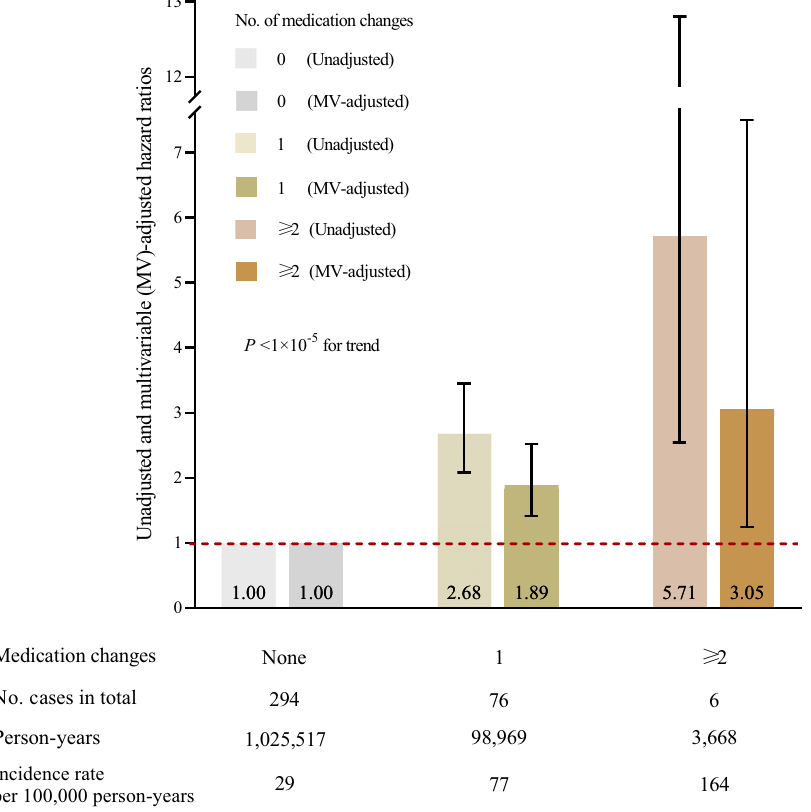
Fig. 2 |Combined associationsofrecent changesinmedicationusewith2-year risk of pancreatic cancer diagnosis. Medication changes include the start of antidiabetic or anticoagulant medications and the stop of antihypertensive medi- cations. Data are presented as the hazard ratios obtained from Cox proportional hazards models in analyses of combined antidiabetic, anticoagulant, and anti- hypertensive medication changes ( n =84,623 biologically independent partici- pants, 376 incident pancreatic cancer cases). Error bars indicate 95% con fi dence intervals. Multivariable-adjusted hazard ratios were strati fi ed by age (in months) and calendar year of the survey cycle (each 2-year interval); and adjusted for race/